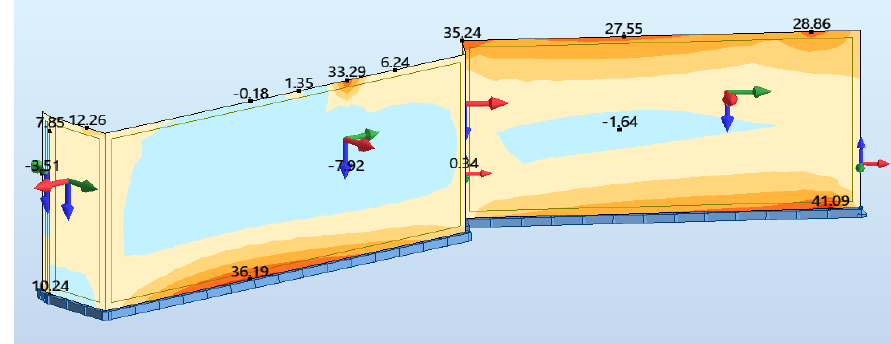
Figure 14. Efforts on the basis of the retaining